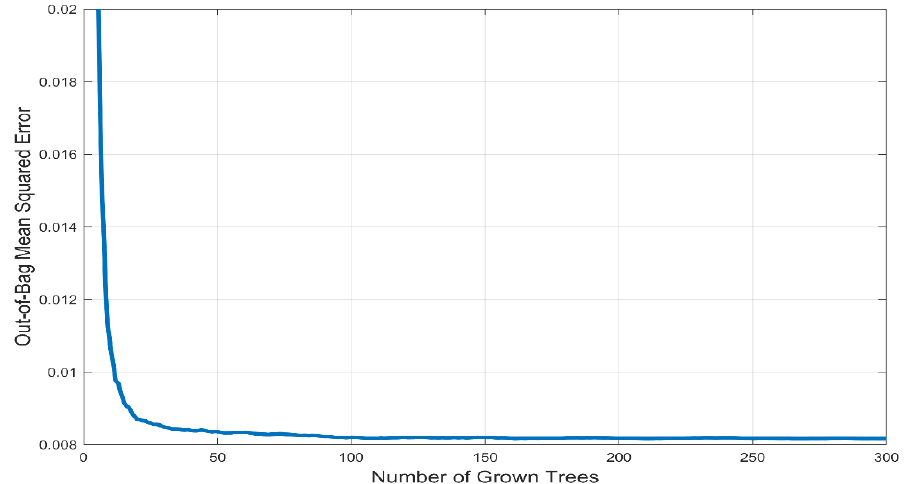
Figure 7. The out of bag mean square error with different numbers of trees in random forest.